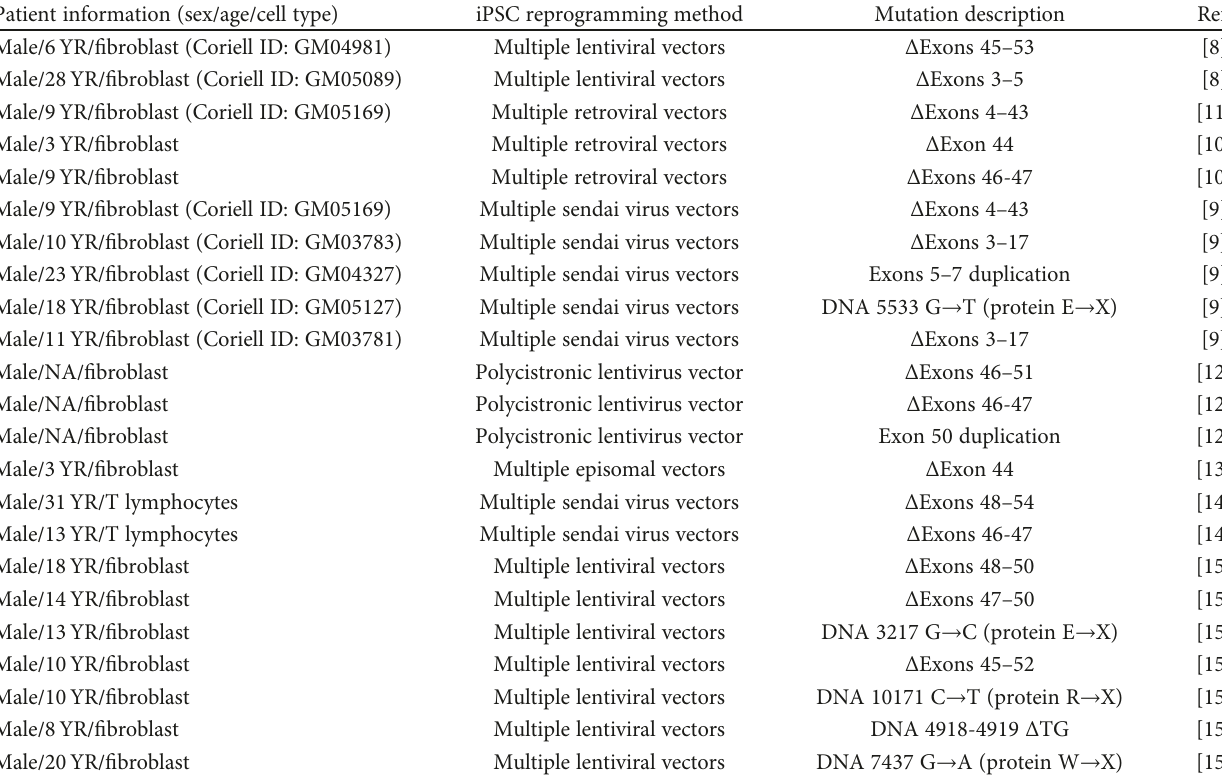
Table 1: Reported DMD-iPSC lines and